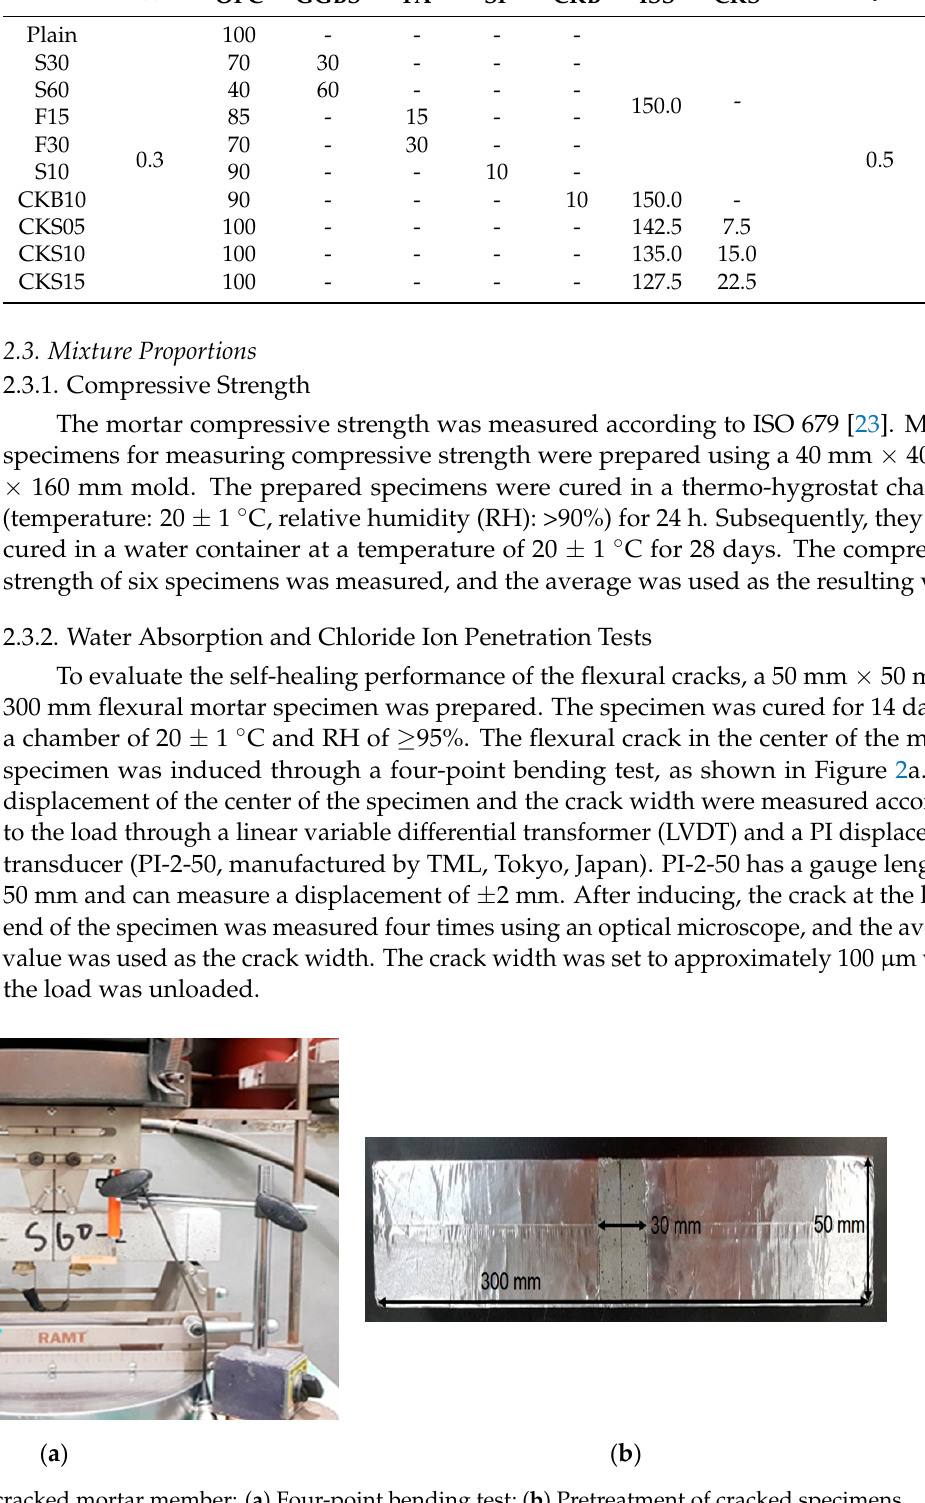
Figure 2. Preparation of cracked mortar member: ( a ) Four-point bending test; ( b ) Pretreatment of cracked specimens.